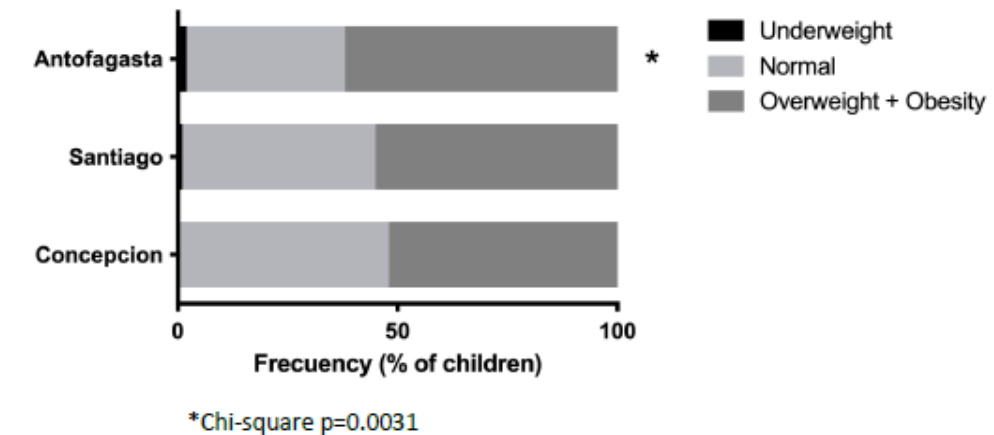
BMI: body mass index. a, b, and c, indicate significant differences between cities (ANOVA and Tukey post hoc test).